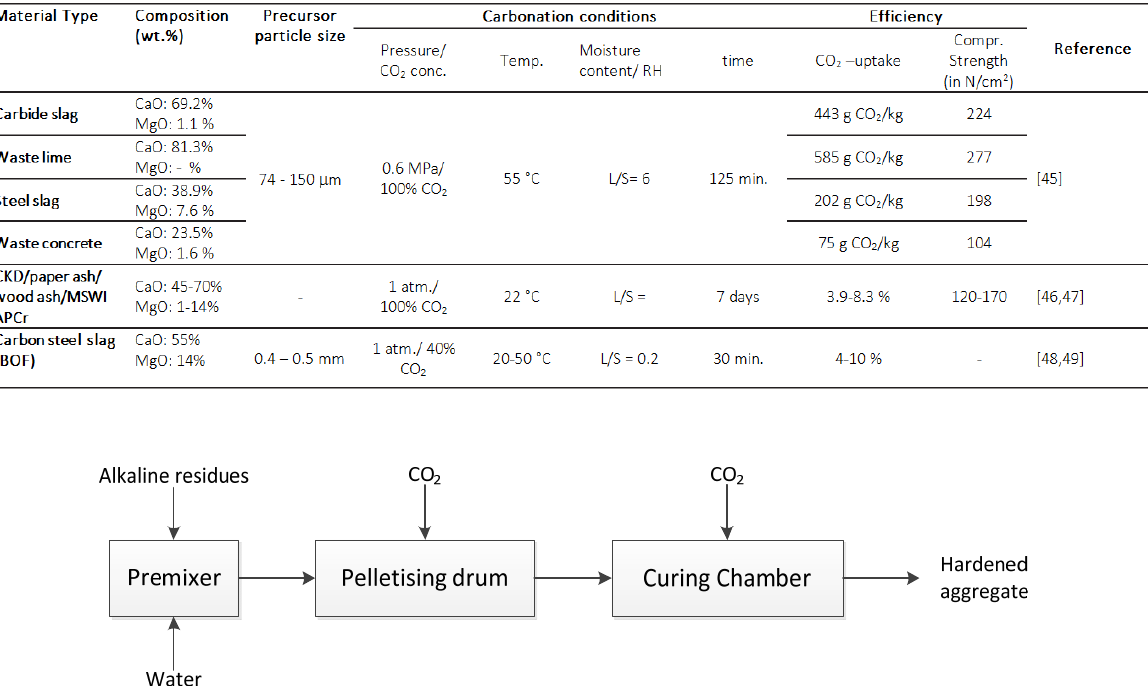
Figure 2. Scheme of a pilot‐scale process proposed for aggregates production based on carbonation of industrial residues. Adapted from